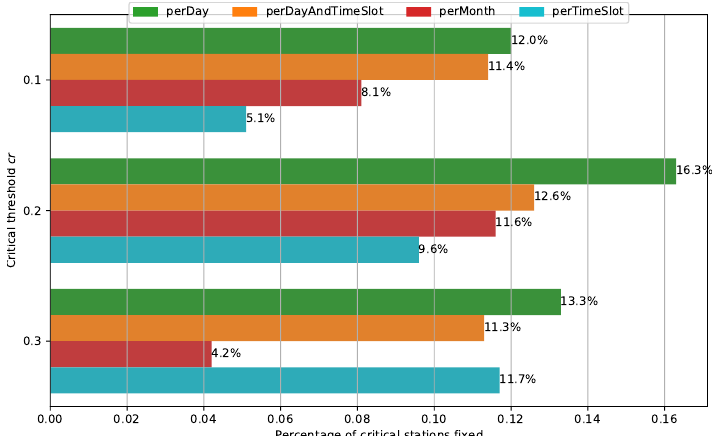
Figure 14. Percentage of fixed station varying cr